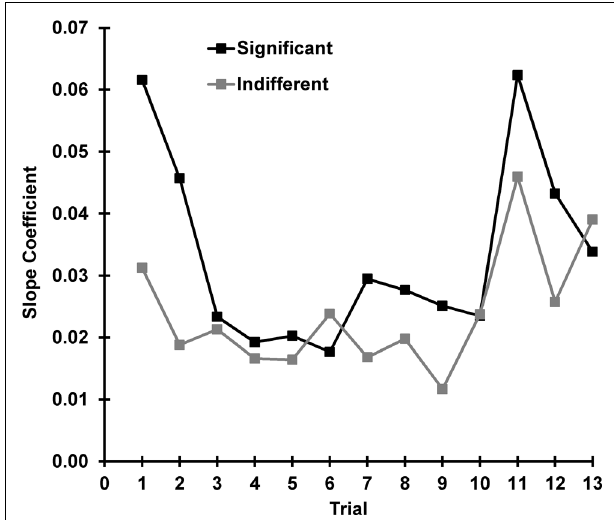
FIGURE 9 | For each trial, the SCR and pre-stimulus SCL were correlated. The slope coefficients for this trial-by-trial comparison are plotted separately for each condition.The novelty and significance of the stimulus appears to determine the strength of the relationship between the OR and the current level of